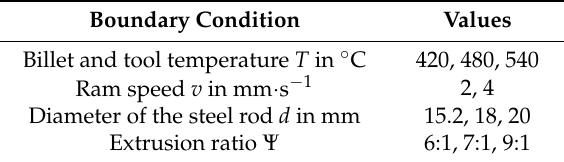
Table 2. Process parameters used in the numerical parametric study.